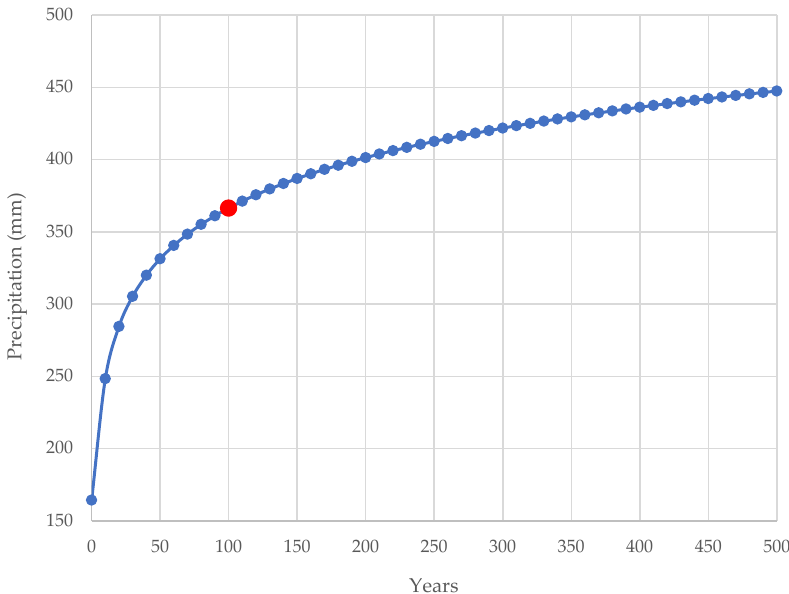
Figure A2. Expected rainfall for São Vicente’s watershed.